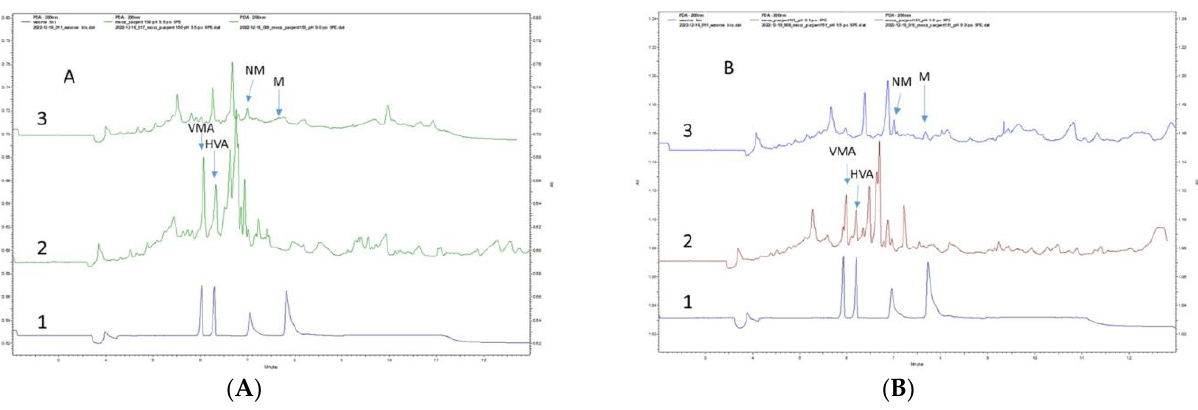
Figure 3. Electropherograms of urine samples from real patients after the SPE-HLB procedure: ( A ) Patient No. 5 and ( B ) Patient No. 6. (1) Standards of analytes in deionized water at a concentration of 10 µg/mL without SPE, (2) urine sample prepared at pH 5.5, and (3) urine sample prepared at pH 9.0. Separation conditions: applied voltage—25 kV; capillary—60.2 cm and 75 µ m i.d.; λ = 200 nm; injection time—15 s. The BGE consisted of 5 mM sodium tetraborate decahydrate, 50 mM SDS, 15% ( v / v ) MeOH, 150 mM boric acid, and 1 mM of [HMIM + Cl − ]. Table 5. Measurements of free concentrations of VMA, HVA, M, and NM in urine samples from 8 pediatric cancer patients.